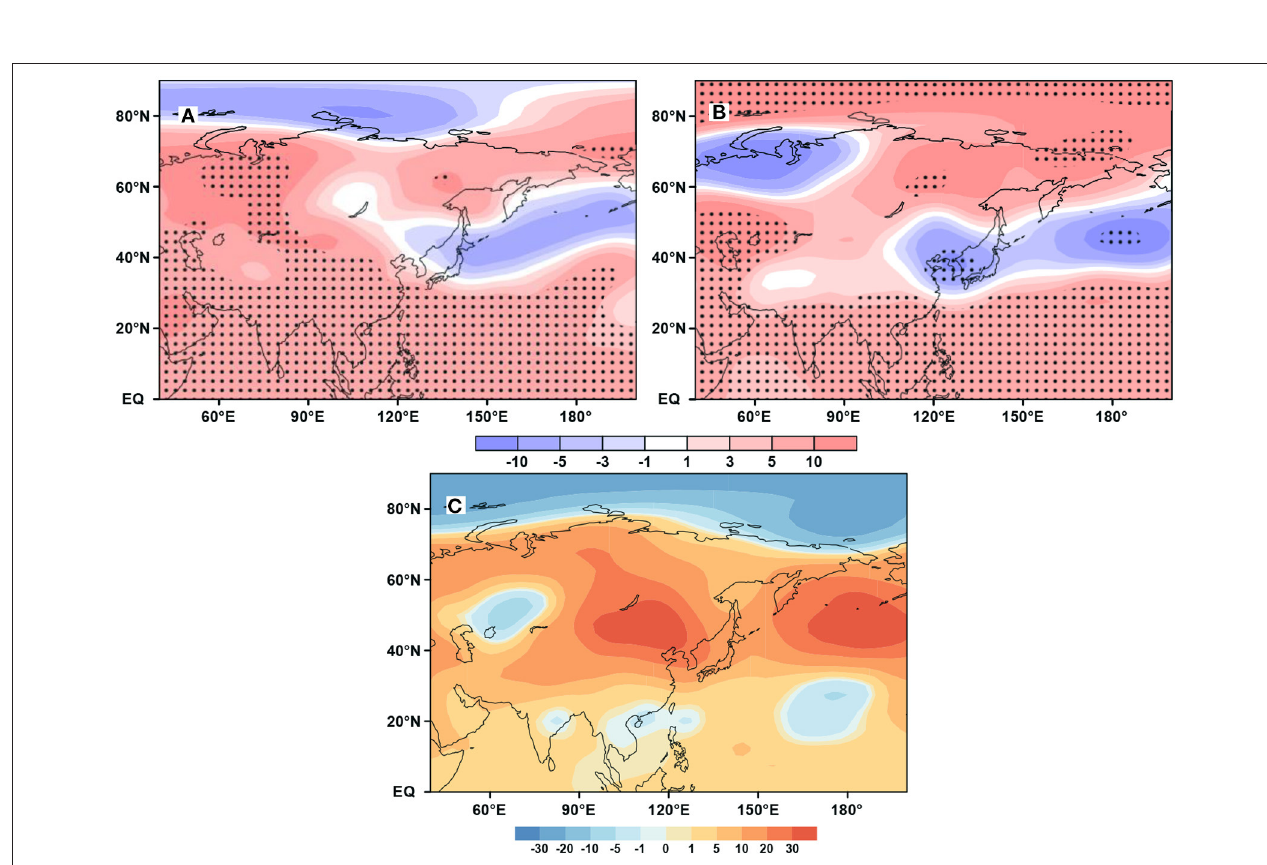
Frontiers in Climate |